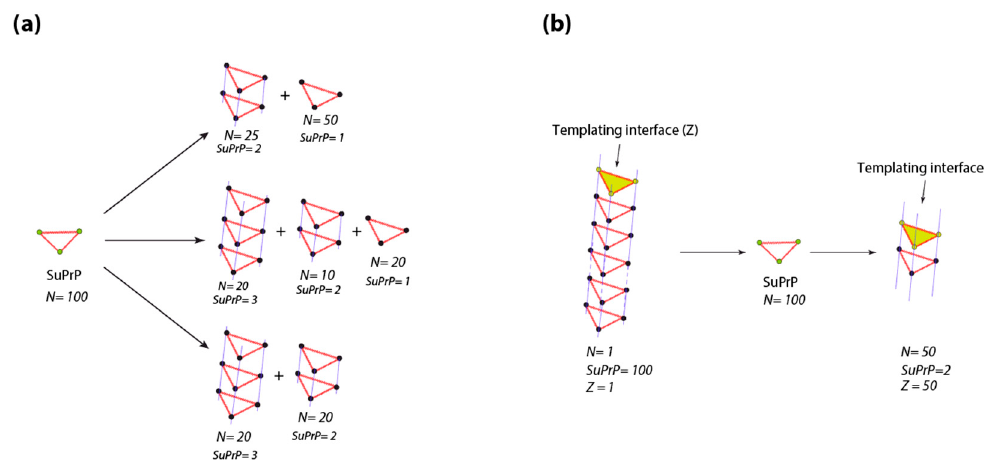
Figure 4. Relation between the number of templating interface and the detailed balance between PrP Sc assemblies and suPrP. ( a ) According to the integer partition law and group representation theory ( p ( N ) = 1 4 N 3 , where N corresponds to the number of elements), 100 of molecules of suPrP can generate trough condensation 10 8 possibility of PrP Sc assemblies differing by size. As an illustration, three of them amongst the 10 8 are presented. ( b ) A PrP Sc assembly formed by the condensation of 100 suPrP presents only one templating interface ( Z = 1). The existence of a detailed balance between PrP Sc assemblies and suPrP makes that the PrP Sc formed by 100 suPrP can rearrange into 50 PrP Sc formed by the stacking of two suPrP, thus increasing the templating interface ( Z = 50).